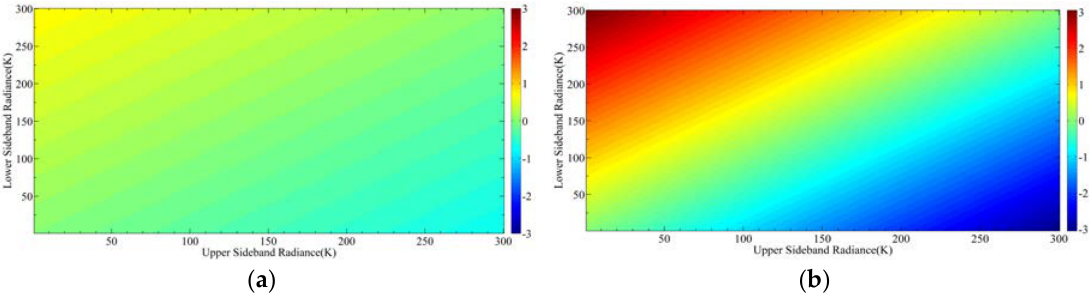
Figure 15. Radiance error caused by the imbalance of two DSB sidebands: ( a ) Imbalance is 0.5%; ( b ) imbalance is 2%.